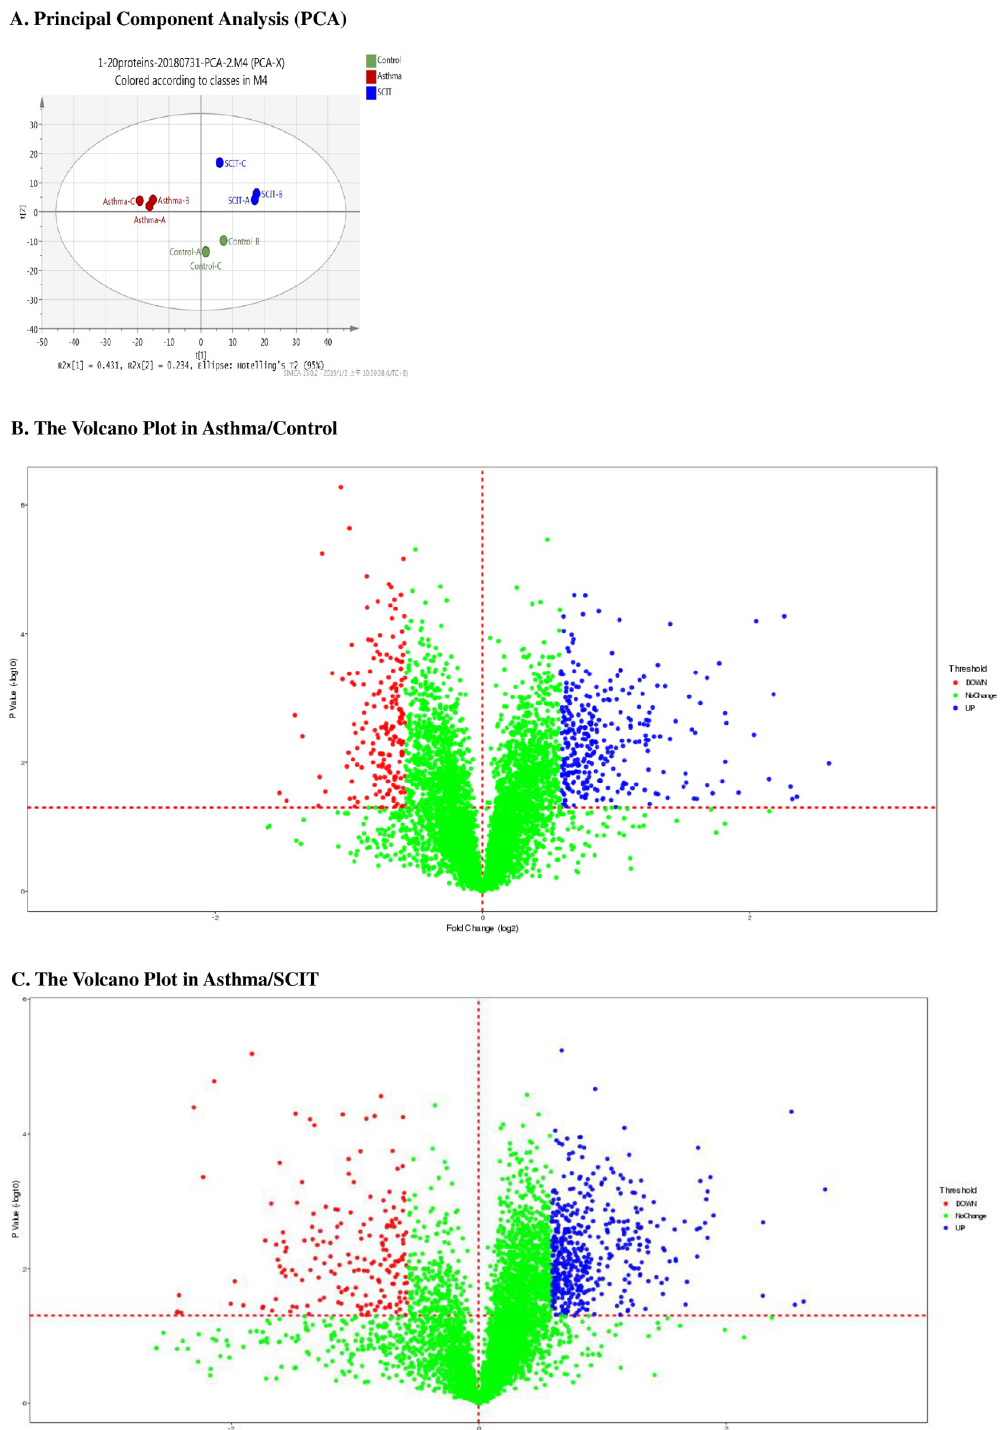
Fig 3. Hierarchical clustering analysis reveals differentially expressed protein profiles proteins between groups. A. Principal component analysis (PCA) showed obvious segregation and aggregation among the three groups, suggesting that our samples were of good quality for further proteomic analysis. B. The volcano plot indicated that the up-regulate (shown in blue) and down-regulate expression (shown in red) proteins of asthma group in comparation with the normal control group (shown in green). C. The volcano plot indicated that the up-regulate (shown in blue) and down-regulate expression (shown in red) proteins of asthma group in comparation with the SCIT group (shown in green).